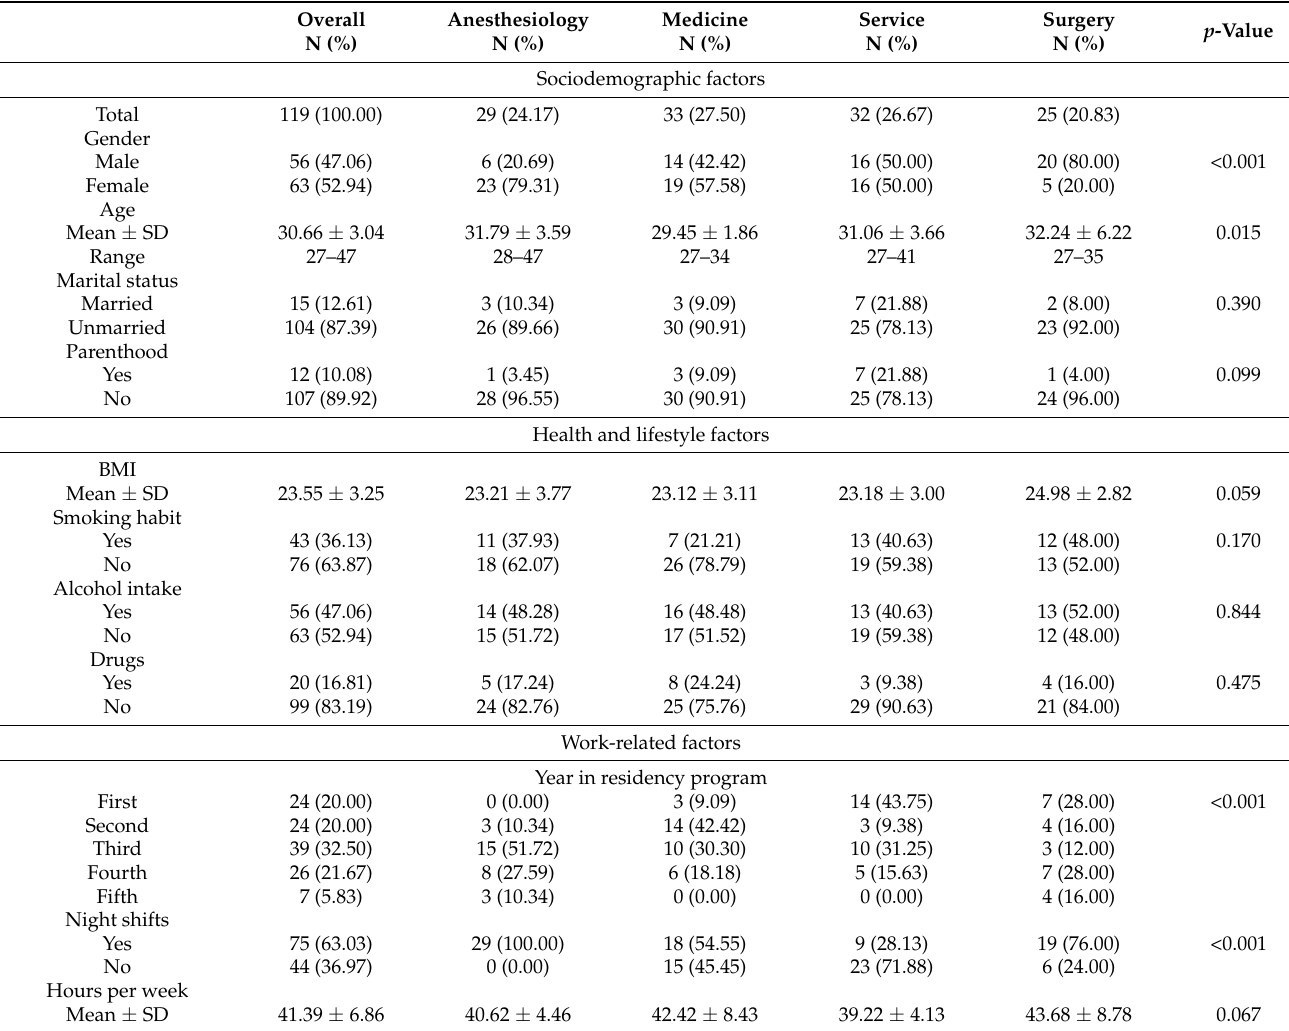
Table 1. Sociodemographic factors and health, lifestyle, and work-related characteristics of the sample, stratified according to specialty